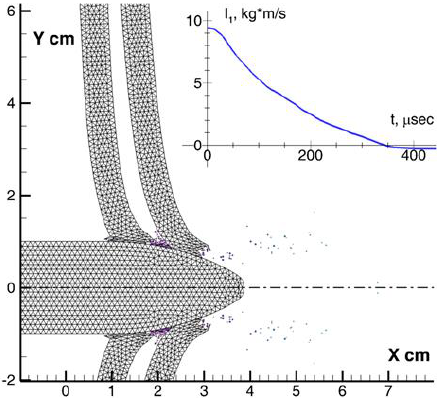
Fig. 2. The position of the hard striker in two- layer steel barrier with the contact of the layers at time t = 400 μ s at the impact speed of 300 m/s (cross-section along the axis with the difference grid), the graph in the right corner is the behavior of the momentum in time.